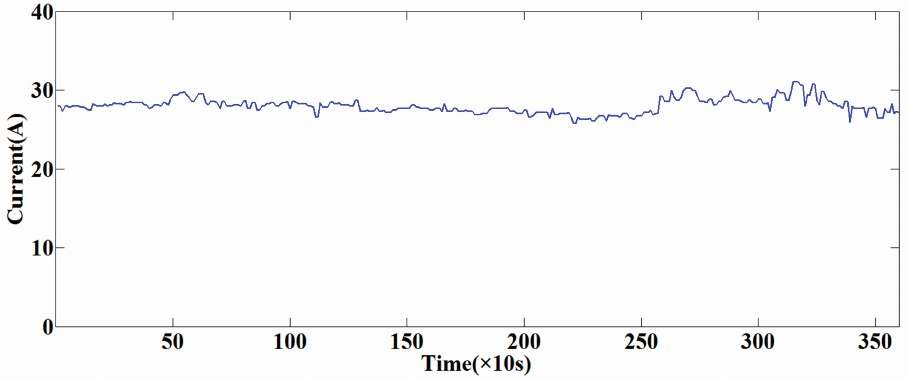
Figure 8. Left cutting current curve in an